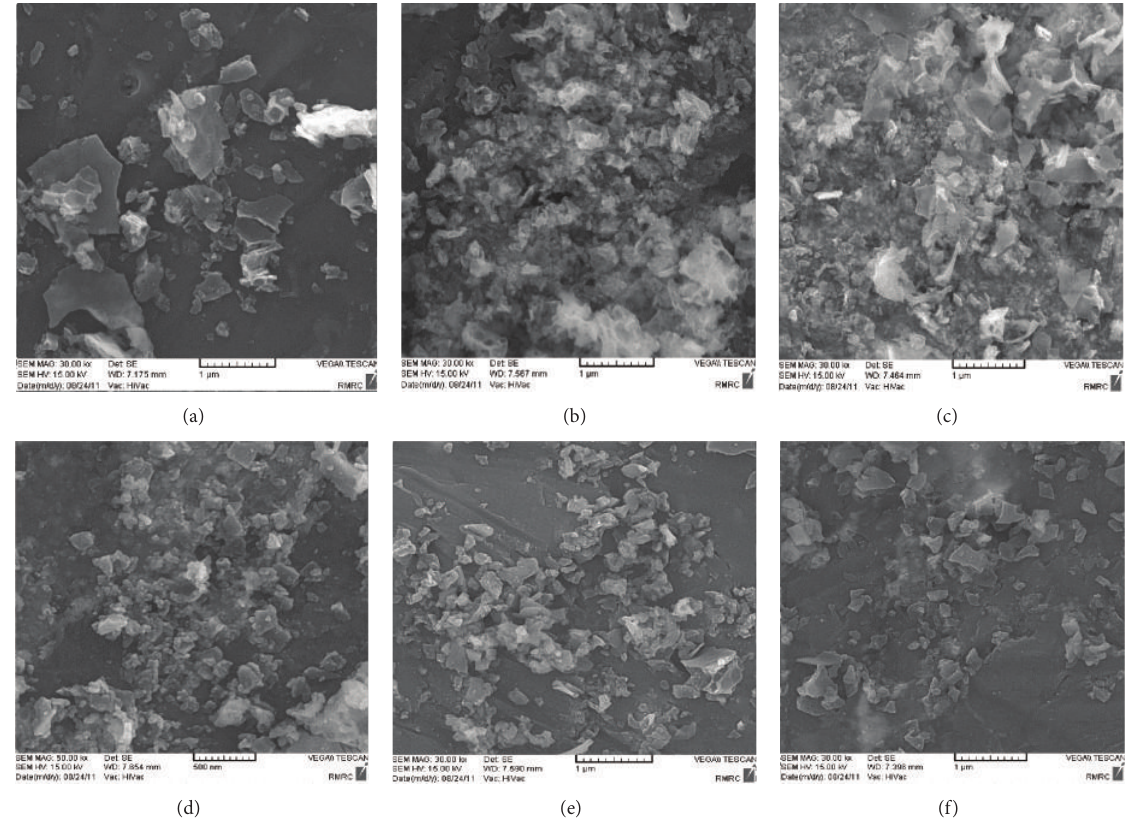
Figure 5: SEM images of the calcined powders of Co